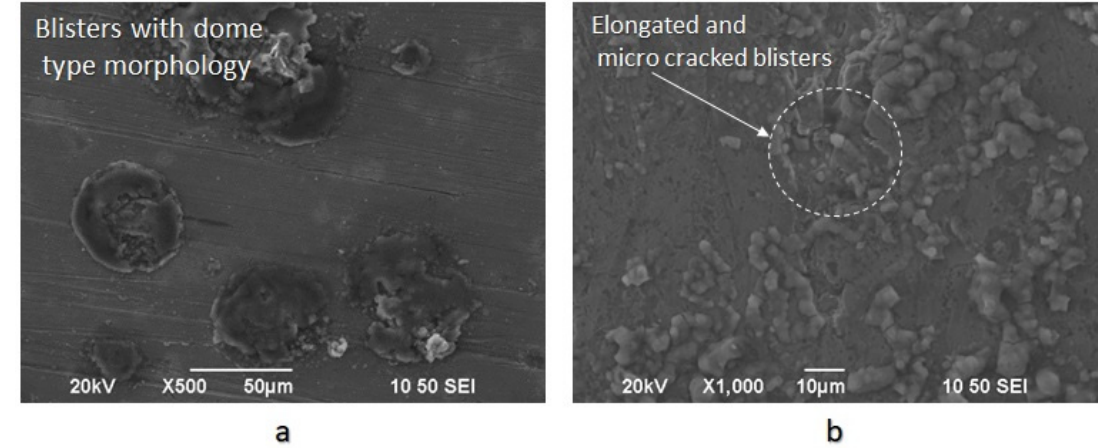
Figure 12. ( a ) Blister formations with a dome-type morphology after the in situ hydrogen cathodic charging process at 10 mA/cm 2 current density under slow strain rate bending loading; ( b ) Elongated blisters with surficial micro-cracks and blistering on blistering nucleation effect after the in situ hydrogen cathodic charging process at 20 mA/cm 2 current density under slow strain rate bending loading.